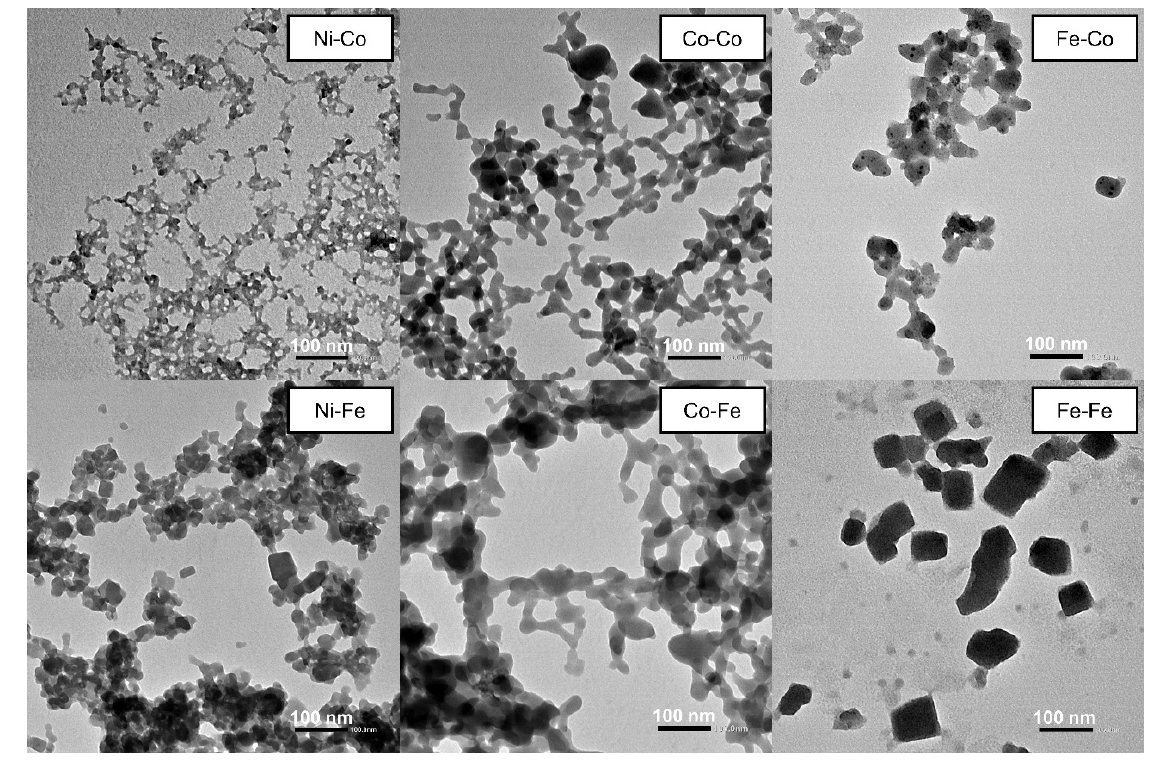
Figure 7. TEM images of the studied porous hexacyanometallates(III).